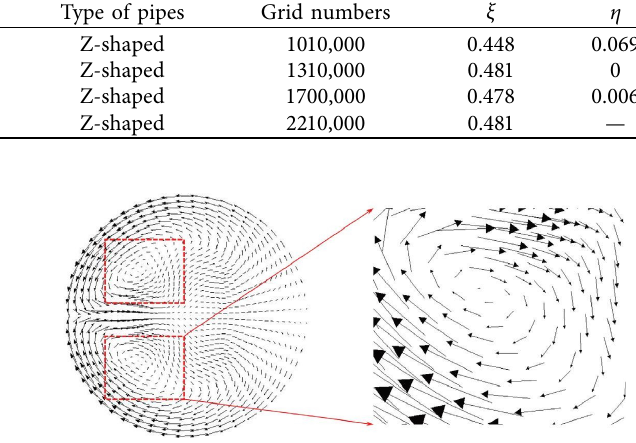
Figure 4: Velocity vector distribution of the cross-section at the bend. Te red dashed boxes indicate the region where vortices are formed.